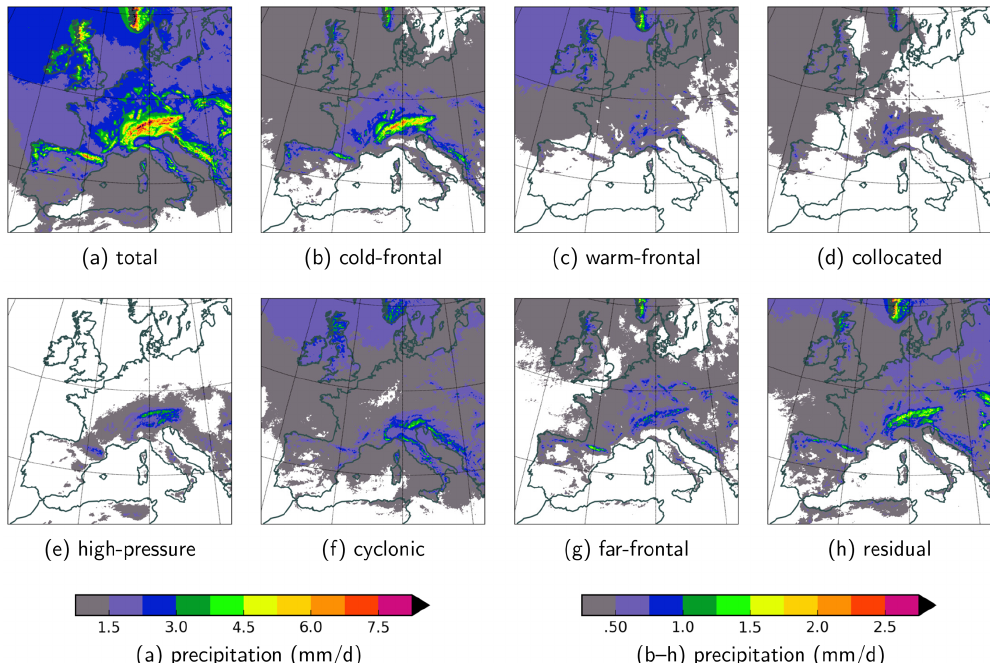
Figure 7. Mean daily precipitation during the 9-year period 2000–2008 (a) overall and (b–h) separated into seven front–cyclone-relative